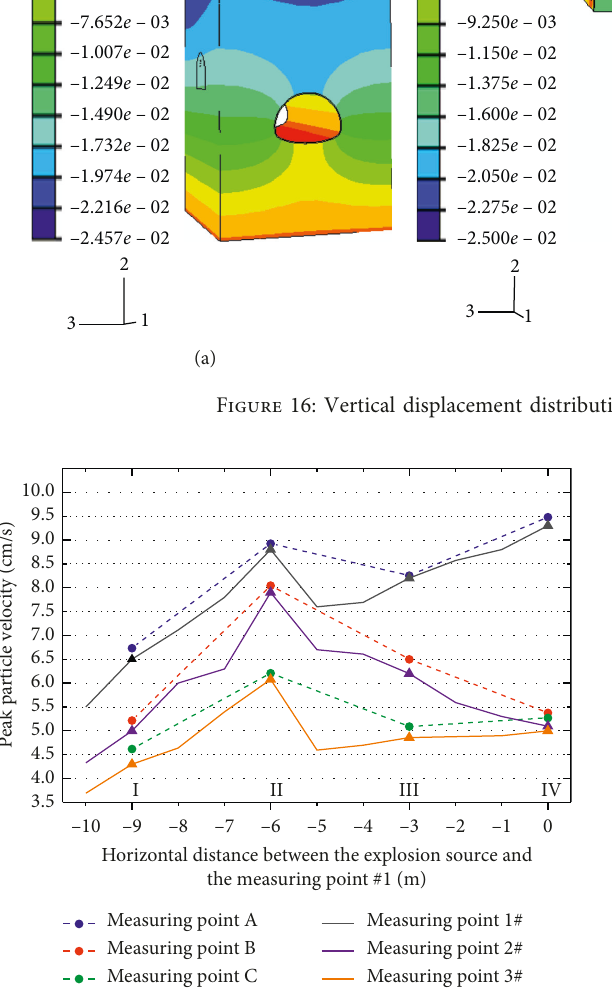
Figure 17: Comparison of PPV between onsite measurements and simulations on Jia Hua Tunnel Left Line.